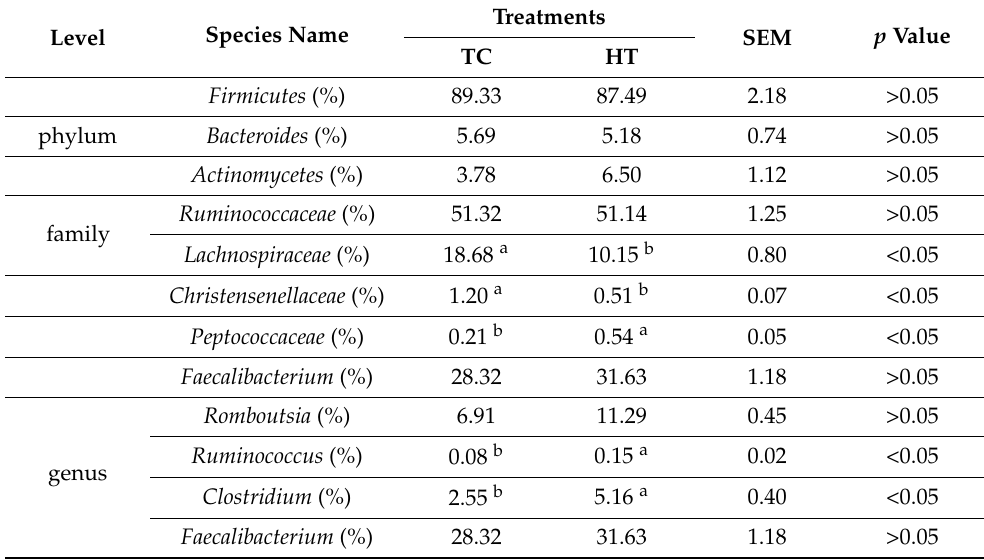
Table 3. Effects of the thermal environment on cecum digesta microbiota composition.